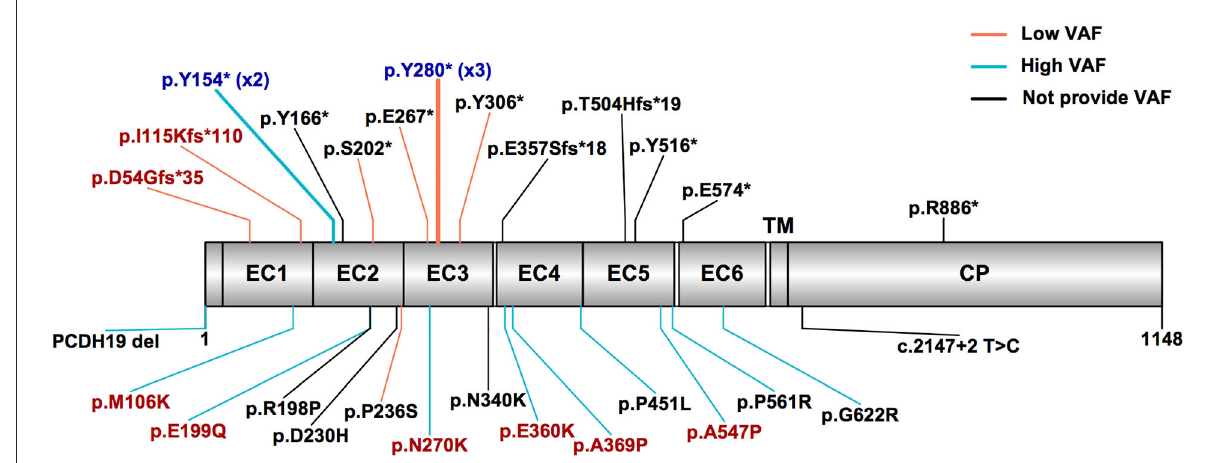
FIGURE2 PCDH19 variants in mosaic male patients with PCDH19 -related epilepsy in our cohort and the published literature. The most common variant types were truncating and missense variants. Patients with high variant allele frequency (VAF > 50%) mostly carried missense variants, while patients with low VAF (VAF ≤ 50%) mostly carried truncating variants. The red text indicates variants found in our cohort patients, the black text indicates variants reported in the literature, and the blue text indicates variants reported in the literature and also found in our cohort. The truncating variants are listed above, and other variants are listed below. The orange line indicates low variant allele frequency, the sky blue line indicates high VAF, and the black line indicates not providing VAF. EC, extracellular cadherin domain, TM, transmembrane domain, CP, cytoplasmic